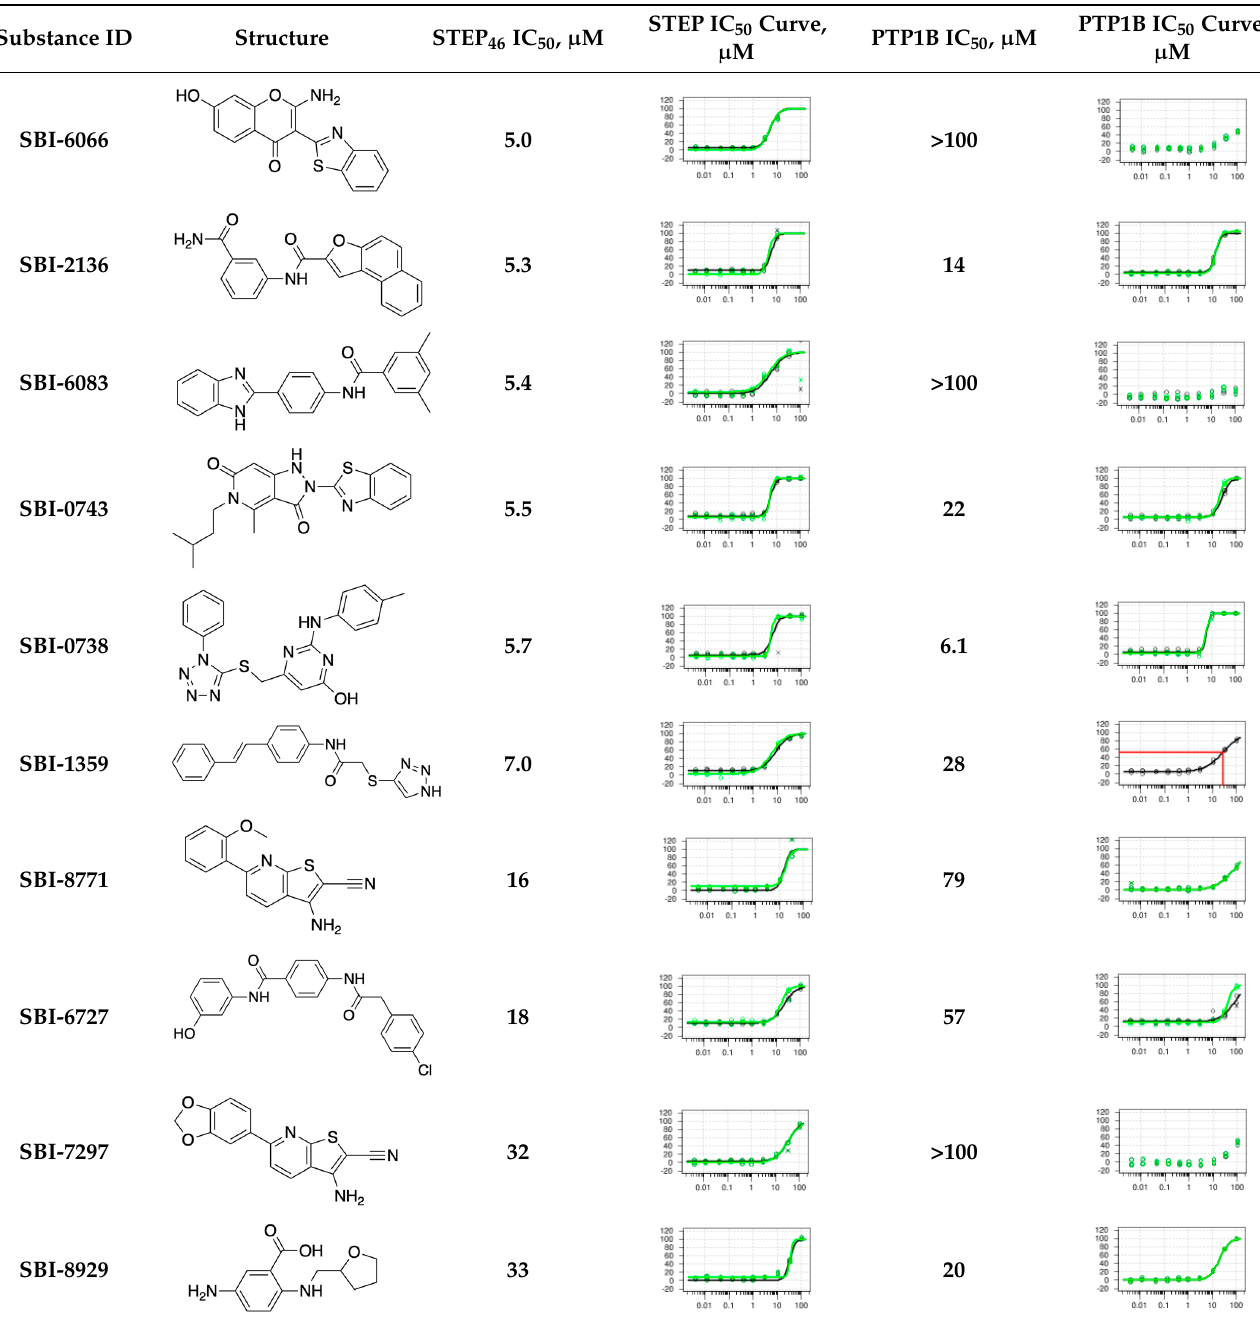
Figure 7. Chemical similarity analysis of 10 powder-confirmed STEP 46 inhibitors using extended- connectivity FingerPrints (ECFPs). Distance calculations were performed with the ICM Pro soft- ware suite (version 3.9, Molsoft, LLC, San Diego, CA, USA). Table 1. Chemical structures of powder-confirmed hits with sub-50 µ M activity against STEP 46 . IC 50 values and correspond- ing dose-response curves with STEP 46 and PTP1B are shown.